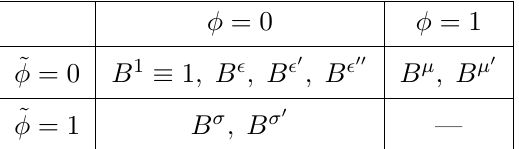
Table 12 . Spinless bulk (cid:12)elds in the fermionic tri-critical Ising model.